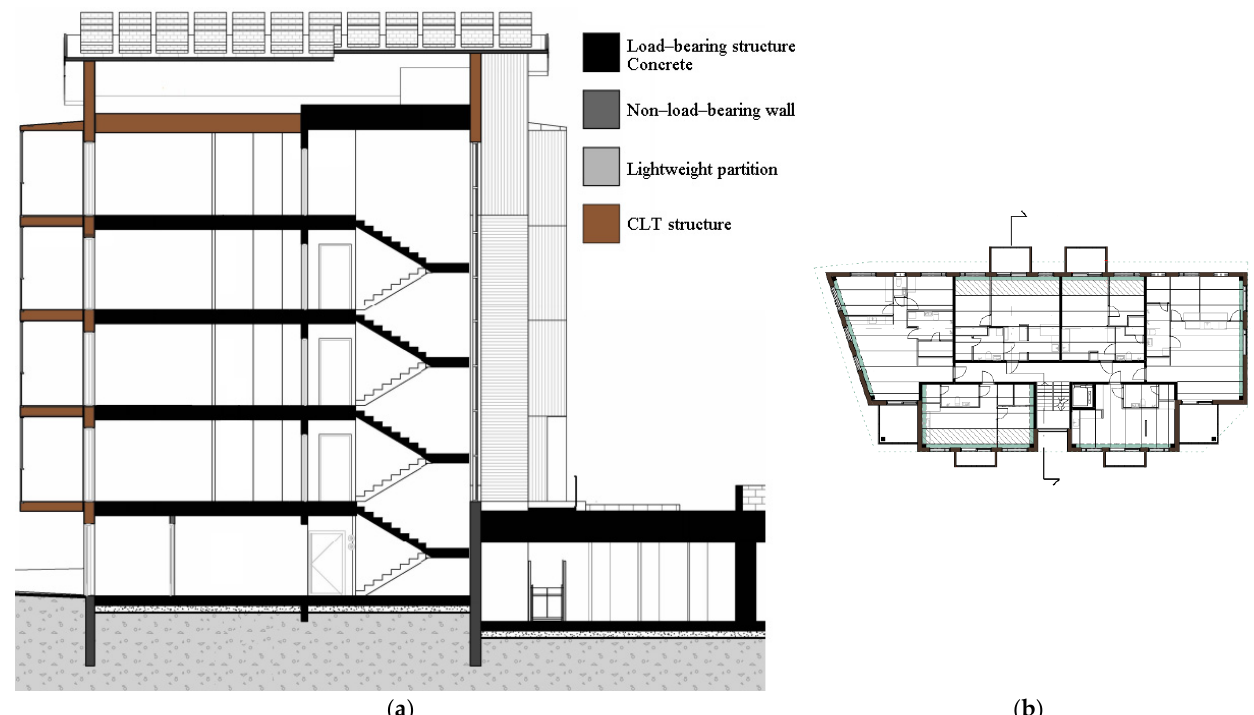
Figure 4. Architectural floor plans: ( a ) general site plan; ( b ) typical floor plan of the hybrid building.